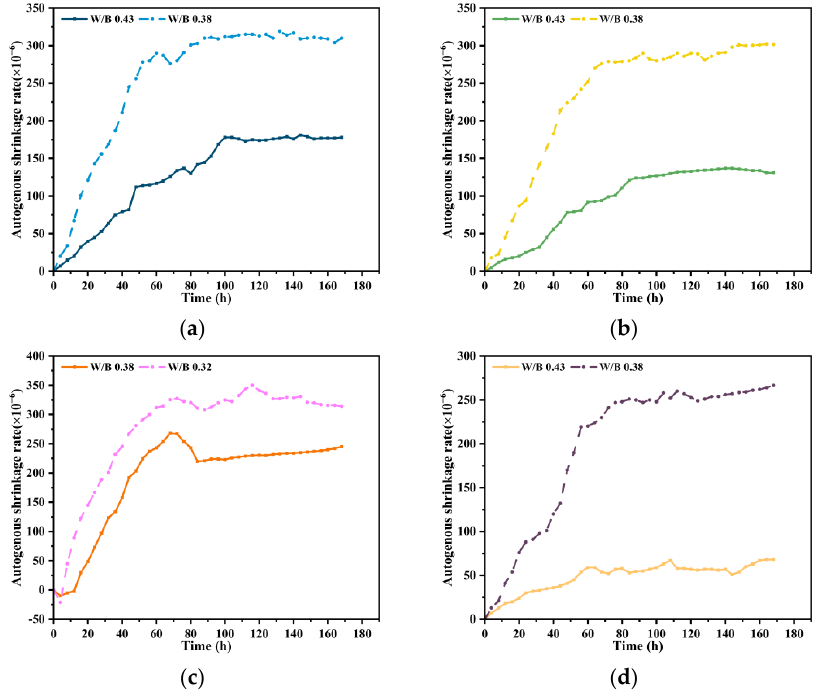
Figure 4. Influence of water-binder ratio on autogenous shrinkage of PMJC. FA: the replacement percentage of fly ash; SF: the replacement percentage of ultra-fine silicon fume; EA: the content of expansive agent. ( a ) PMJC13 and PMJC16 (FA: 20%, SF: 0, EA: 0). ( b ) PMJC14 and PMJC17 (FA: 30%, SF: 0, EA: 0). ( c ) PMJC19 and PMJC21 (FA: 30%, SF: 0, EA: 0.8%). ( d ) PMJC15 and PMJC18 (FA: 30%, SF: 3%).